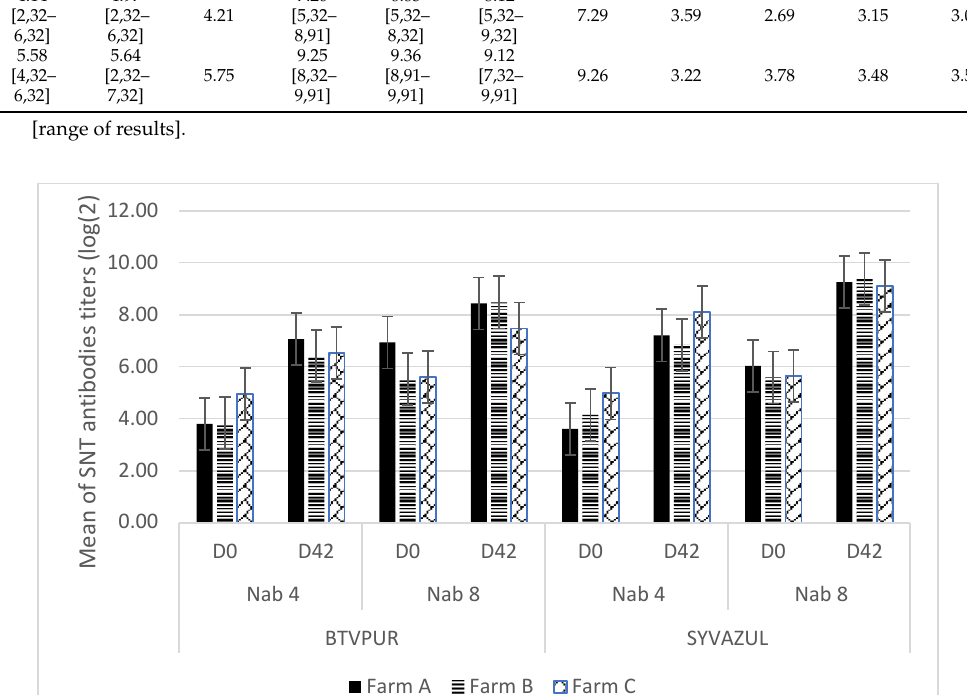
Figure 2. Evolution of neutralizing antibodies (Nab) in the three farms (A, B, C) according to the vaccine used as a booster (vertical bars represent ± 1 standard error). Nab 4: neutralizing antibodies against BTV-4; Nab 8: neutralizing antibodies against BTV-8; D0: day 0 prior to booster vaccination; D42: day 42 after booster vaccination.